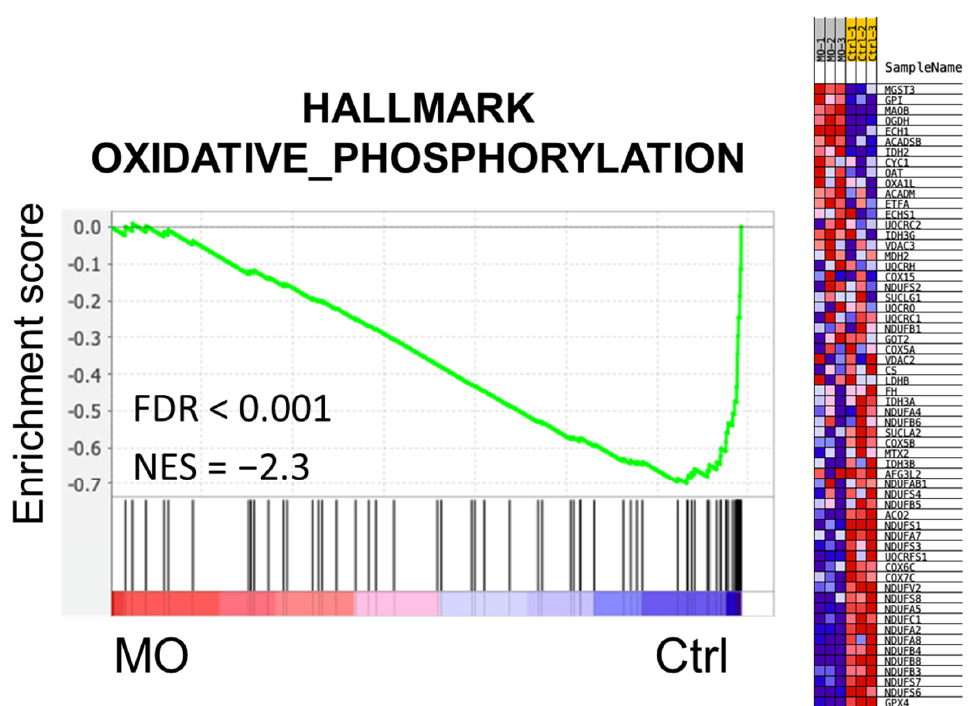
Figure 4. MO diminished oxidative phosphorylation in HCT116 cells. Gene set enrichment analysis (GSEA) was applied to elucidate the effects of MO on CRC cells. Oxidative phosphorylation (OXPHOS) was enriched in the control group with an FDR < 0.001 and NES = − 2.3, indicating a strong negative effect of MO on OXPHOS. Proteins involved in OXPHOS are shown on the right panel with their relative expression levels in MO-treated and control groups.